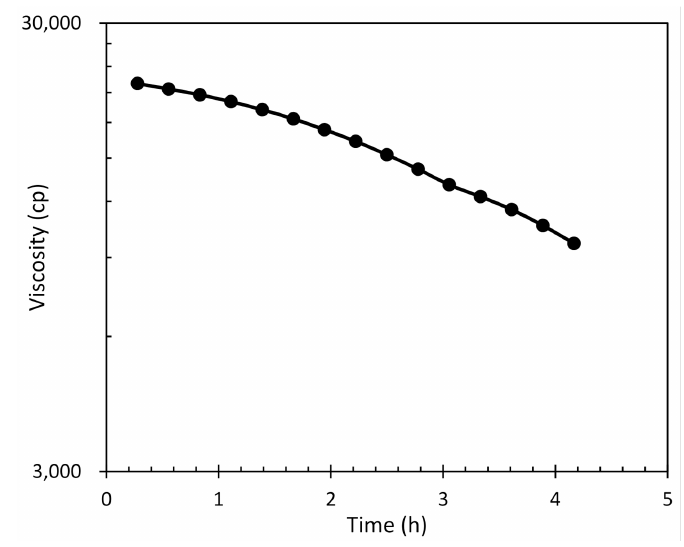
Figure 14. Averaged oil viscosity as a function of